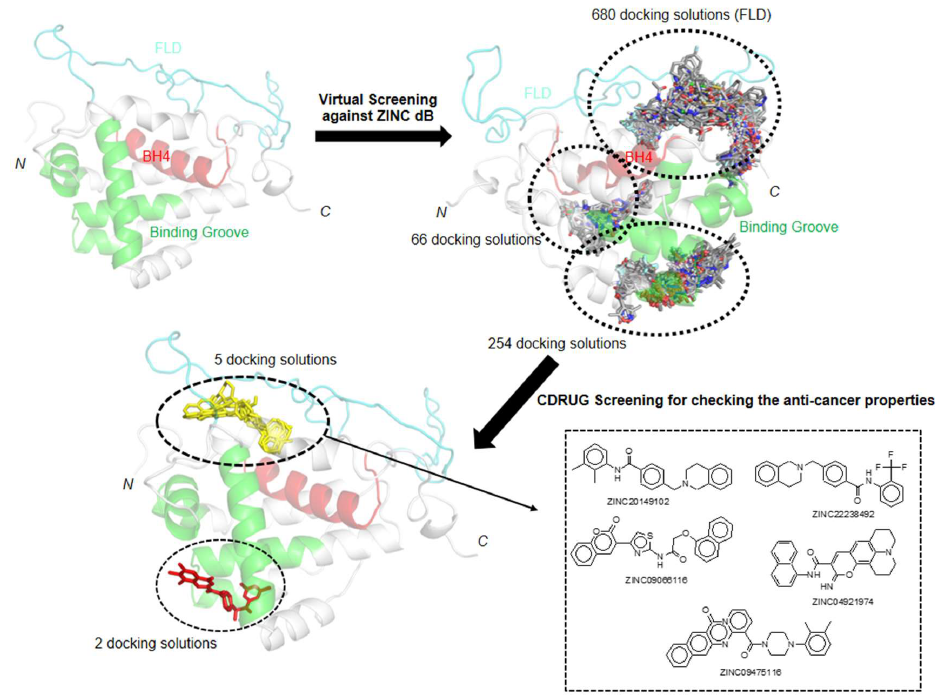
Figure 4. Schematic representation of virtual screening work flow to screen the possible FLD binders for Physiological Bcl-2 form.